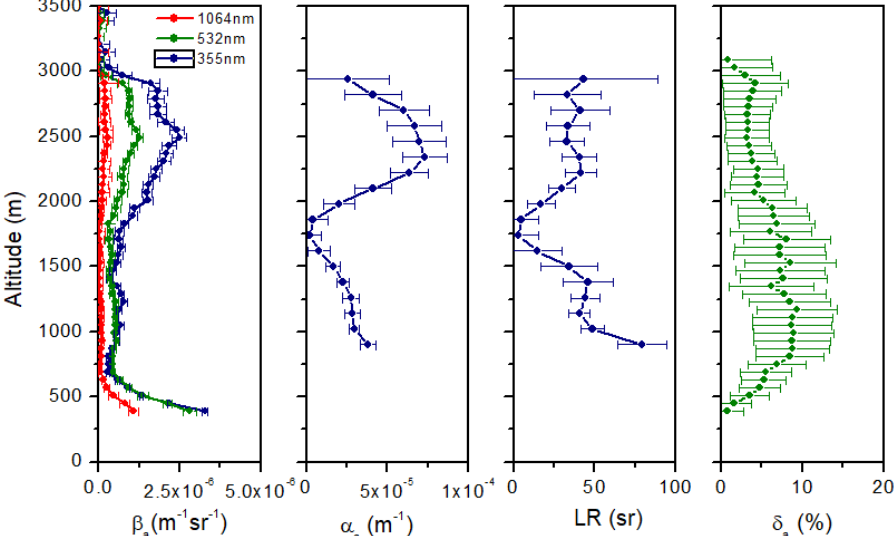
Figure 16. Lidar profiles of aerosol backscattering ( β a ), extinction ( α a ), lidar ratio (LR) and linear depolarization ( δ a ) derived from Raman lidar observations carried out on 13 July 2017 in Naples.